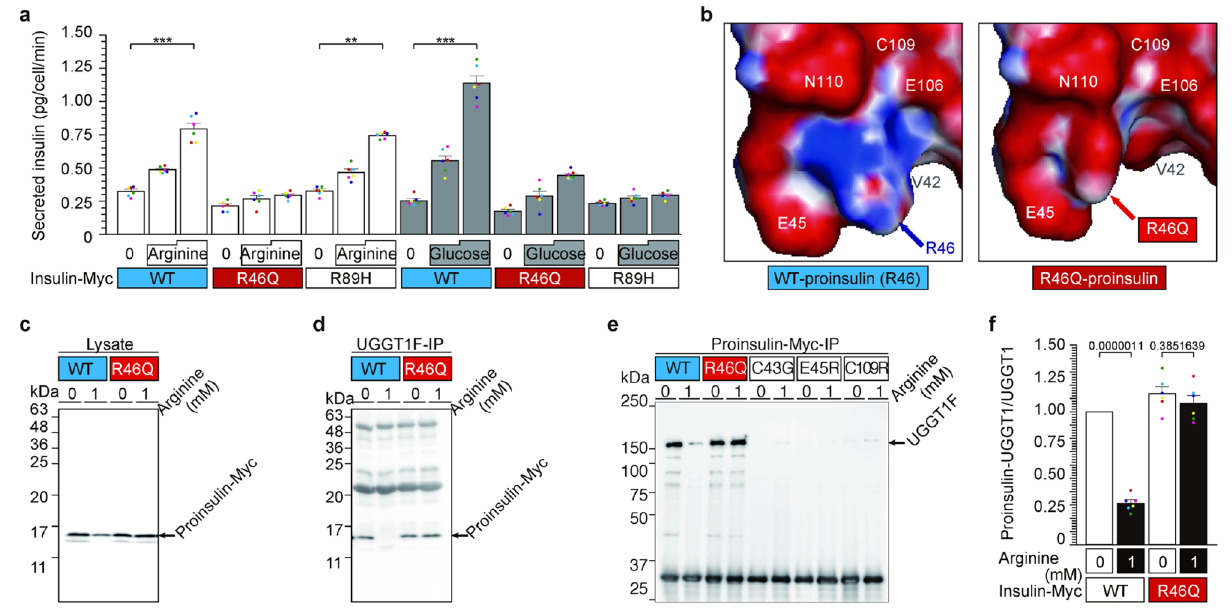
Figure 1. The R46 residue of proinsulin is involved in arginine-induced insulin secretion. ( a ) The R46 residue of proinsulin is involved in arginine-induced insulin secretion. NIT1 cells transfected with insulin-Myc vectors expressing WT, R46Q, and R89H were preincubated with arginine- or glucose-free F-12 K medium for 30 min. Then, the cells were treated with arginine or glucose for 5 min. The culture supernatant was collected, and secreted insulin was analyzed by ELISA. Data are presented as mean ± S.E. n = 6 ** p < 0.005; *** p < 0.0001. ( b ) The predicted structure of R46 (WT) and R46Q proinsulin. Protruding R46 residue and surrounding amino acid ring of proinsulin. Basic groups are shown in blue, and acidic groups are shown in red. The original structural data of proinsulin (https:// www. rcsb. org/ struc ture/ 3w7y) were used 28 . The non-protruding R46Q residue was calculated using PyMOL software. Other directions of the R46 and R46Q structures are shown in Fig. S1a. ( c , and d ) R46Q-mutated proinsulin protein bound to UGGT1 and was retained in the ER with/ without arginine. NIT1 cells transfected with WT or R46Q proinsulin were pretreated in arginine-free F-12 k for 30 min and stimulated with 1 mM arginine for 5 min. Intracellular proinsulin and UGGT1 were analyzed by WB ( c and Fig. S1b). Proinsulin bound to UGGT1 was assessed by IP of UGGT1 followed by IP-WB ( d and Fig. S1c). ( e , and f ) Three proinsulin variants of the acid ring consisting of V42, C43, E45, E106,